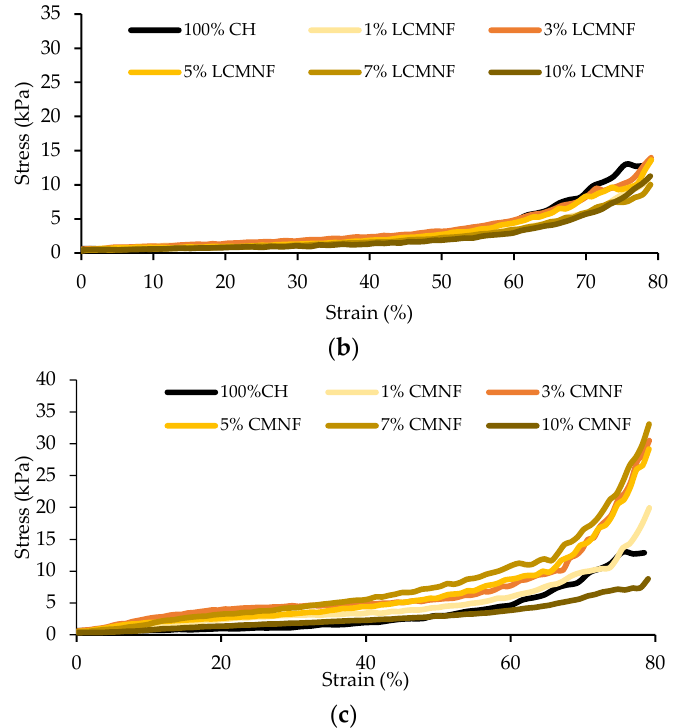
Figure 2. ( a ) Compressive strength, ( b ) stress-strain curves of the prepared LCMNF-CH and CMNF-CH aerogels. ( c ) CMNF-CH